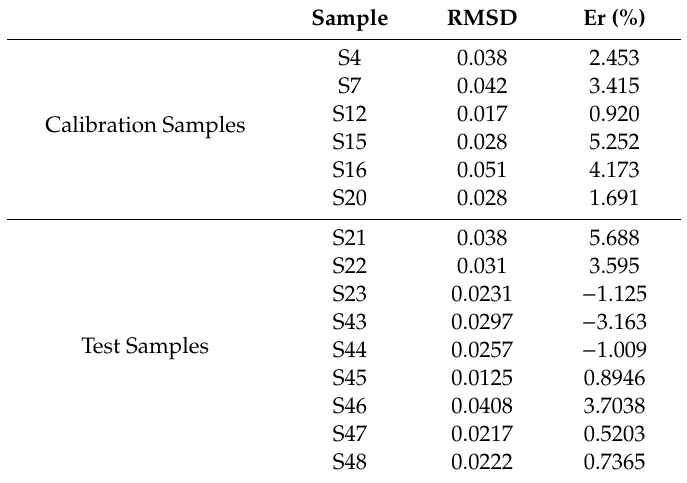
Table 3. Root-Mean-Square Deviation (RMSD) and error index 510–645